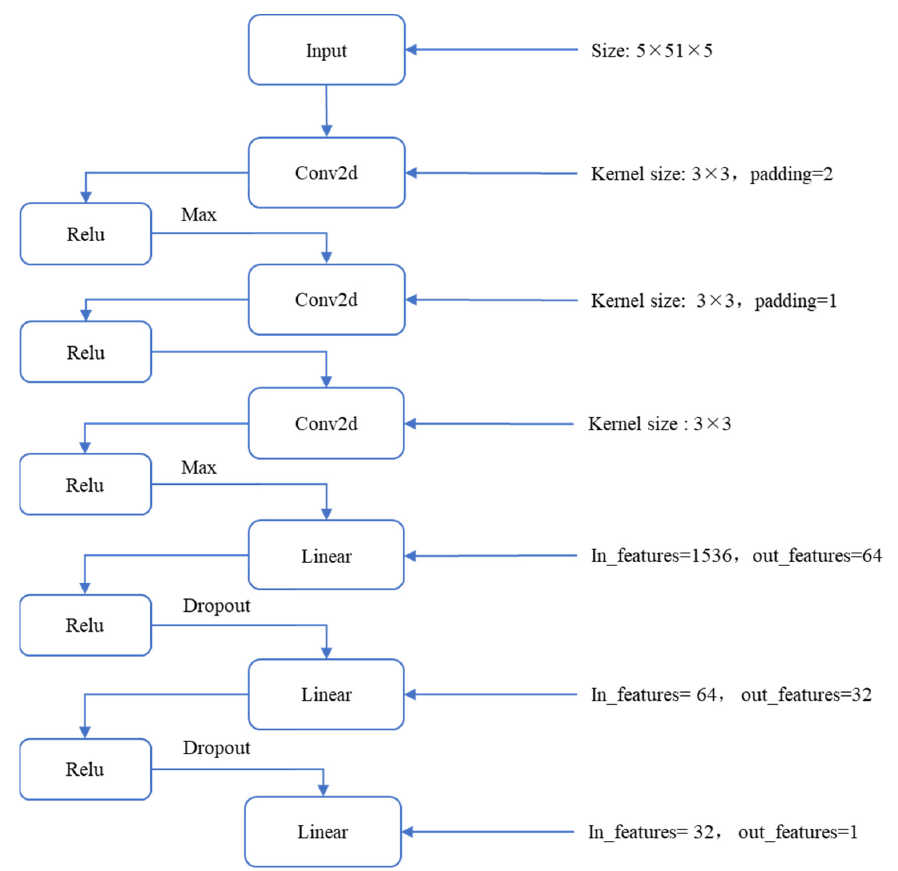
Figure 9. The neural network structure of critic.